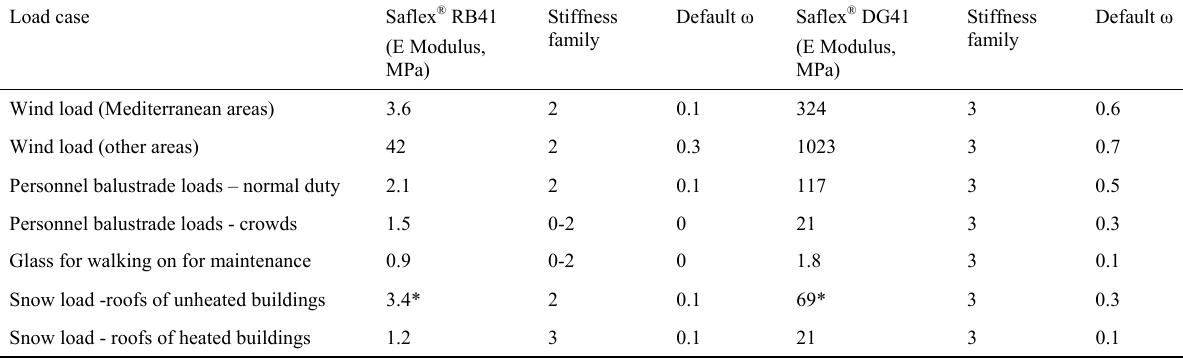
Table 5: Stiffness family determination as per pr EN16613 for Saflex ® RB41 interlayer and Saflex ® DG41